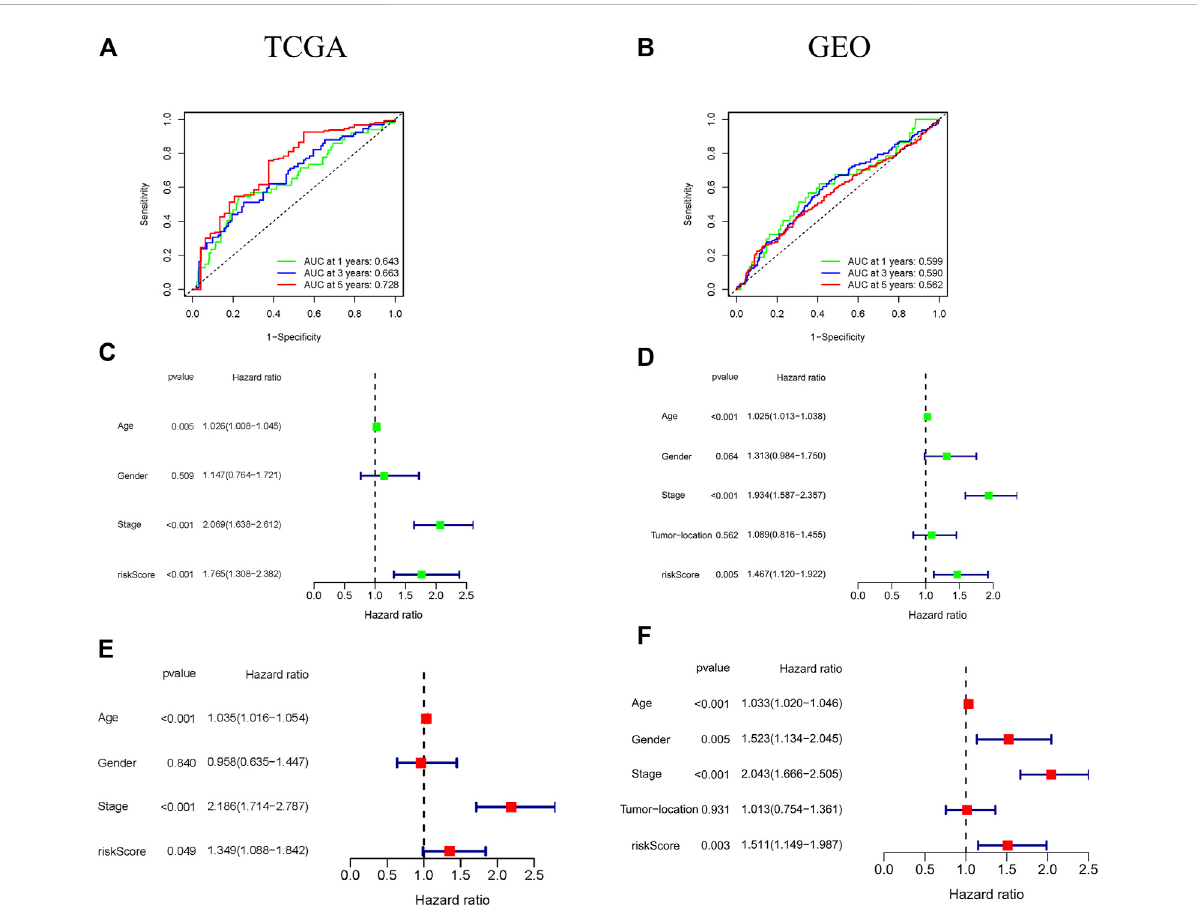
FIGURE 3 Prognostic signi fi cance of the ferroptosis-associated gene signature in CRC patients from the TCGA and GEO cohorts. (A,B) ROC curves indicated the accuracy of the ferroptosis-associated gene signature in the prediction of survival rates at 1-, 3-, and 5-years; (C – F) The independent prognostic signi fi cance of the ferroptosis-associated gene signature in OS in CRC patients using univariate and multivariate Cox